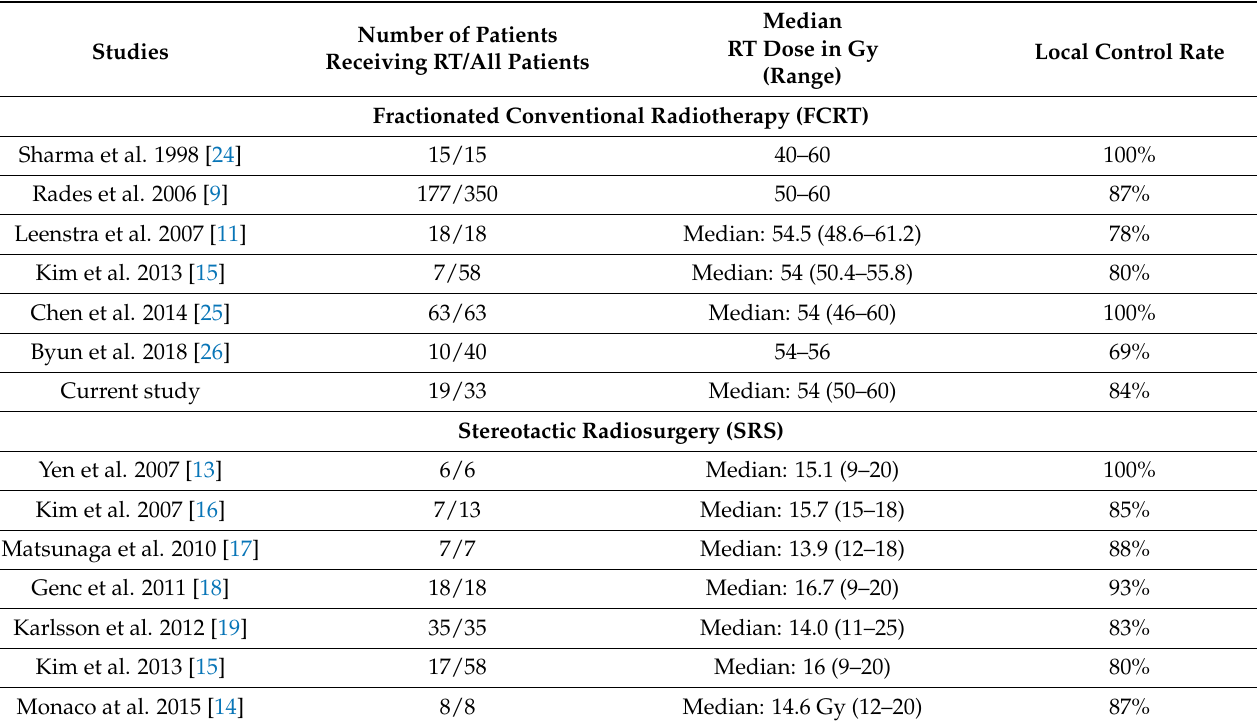
Table 2. Review of